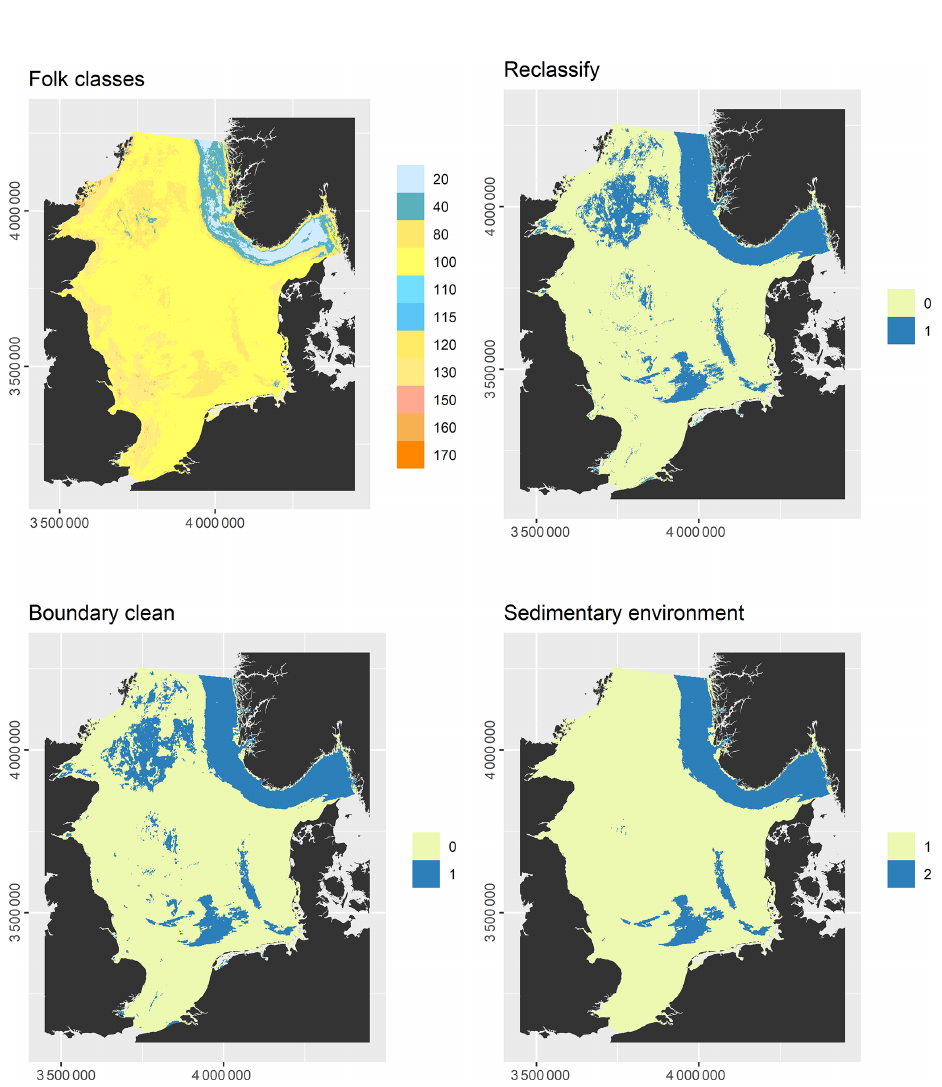
Figure A1. Derivation of the sedimentary environment layer: Folk textural classes were derived from sediment composition predicted by Mitchell et al. (2019a). 20 – mud, 40 – sandy mud, 80 – muddy sand, 100 – sand, 110 – gravelly mud, 115 – gravelly sandy mud, 120 – gravelly muddy sand, 130 – gravelly sand, 150 – muddy sandy gravel, 160 – sandy gravel, 170 – gravel. Mud, sandy mud, and muddy sand were reclassified as potential accumulation (1), the remainder as erosion/non-deposition (0) areas. The polygons were simplified with the “Boundary Clean” tool in ArcGIS. The potential accumulation areas were critically reviewed in the light of measured sedimentation rates and geological interpretations of sediment cores (de Haas et al., 1997, and references therein) and the dominant areas of erosion/net-deposition (1) and sediment accumulation